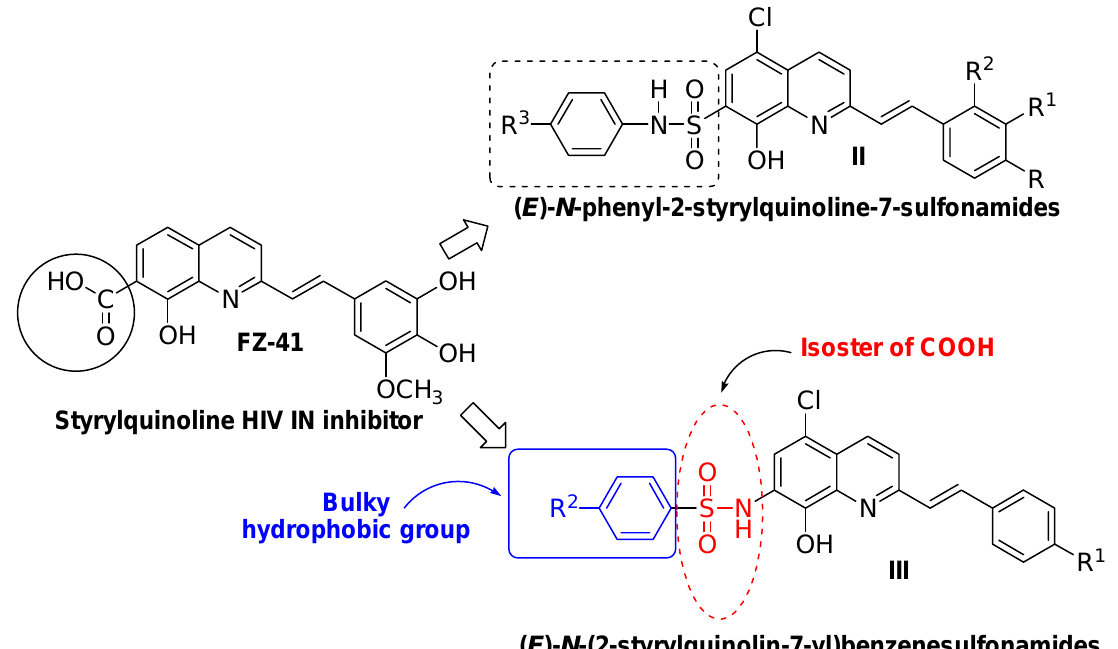
Figure 1. The design of N -(2-styrylquinolin-7-yl)benzenesulfonamides as potential HIV IN